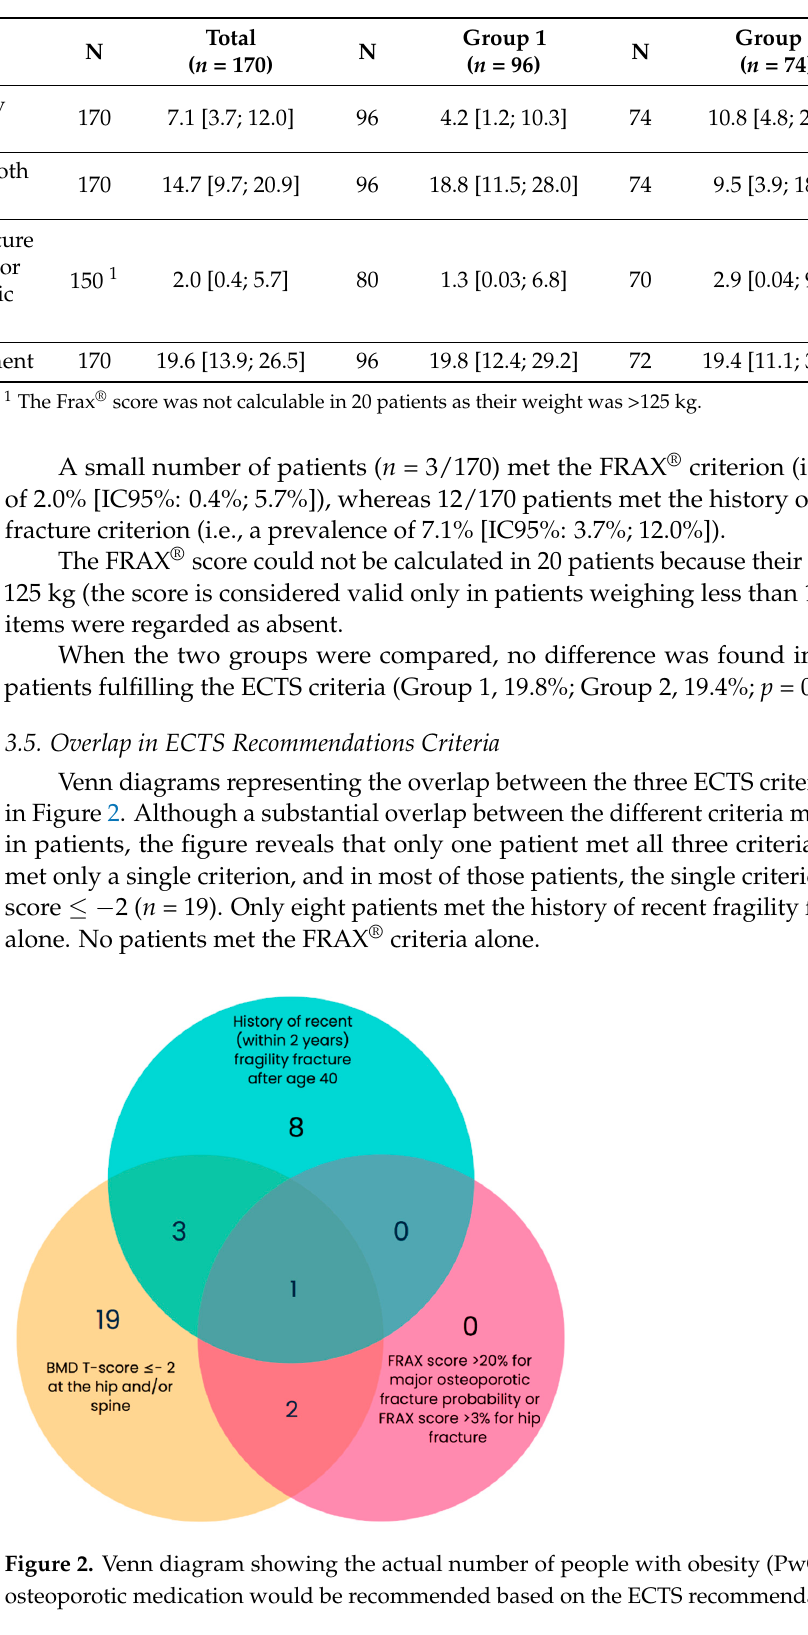
Table 4. Prevalence of postmenopausal women and men aged 50 years and older meeting criteria for anti- osteoporosis medication based on the 2022 European Calcified Tissue Society (ECTS) Recommendations.